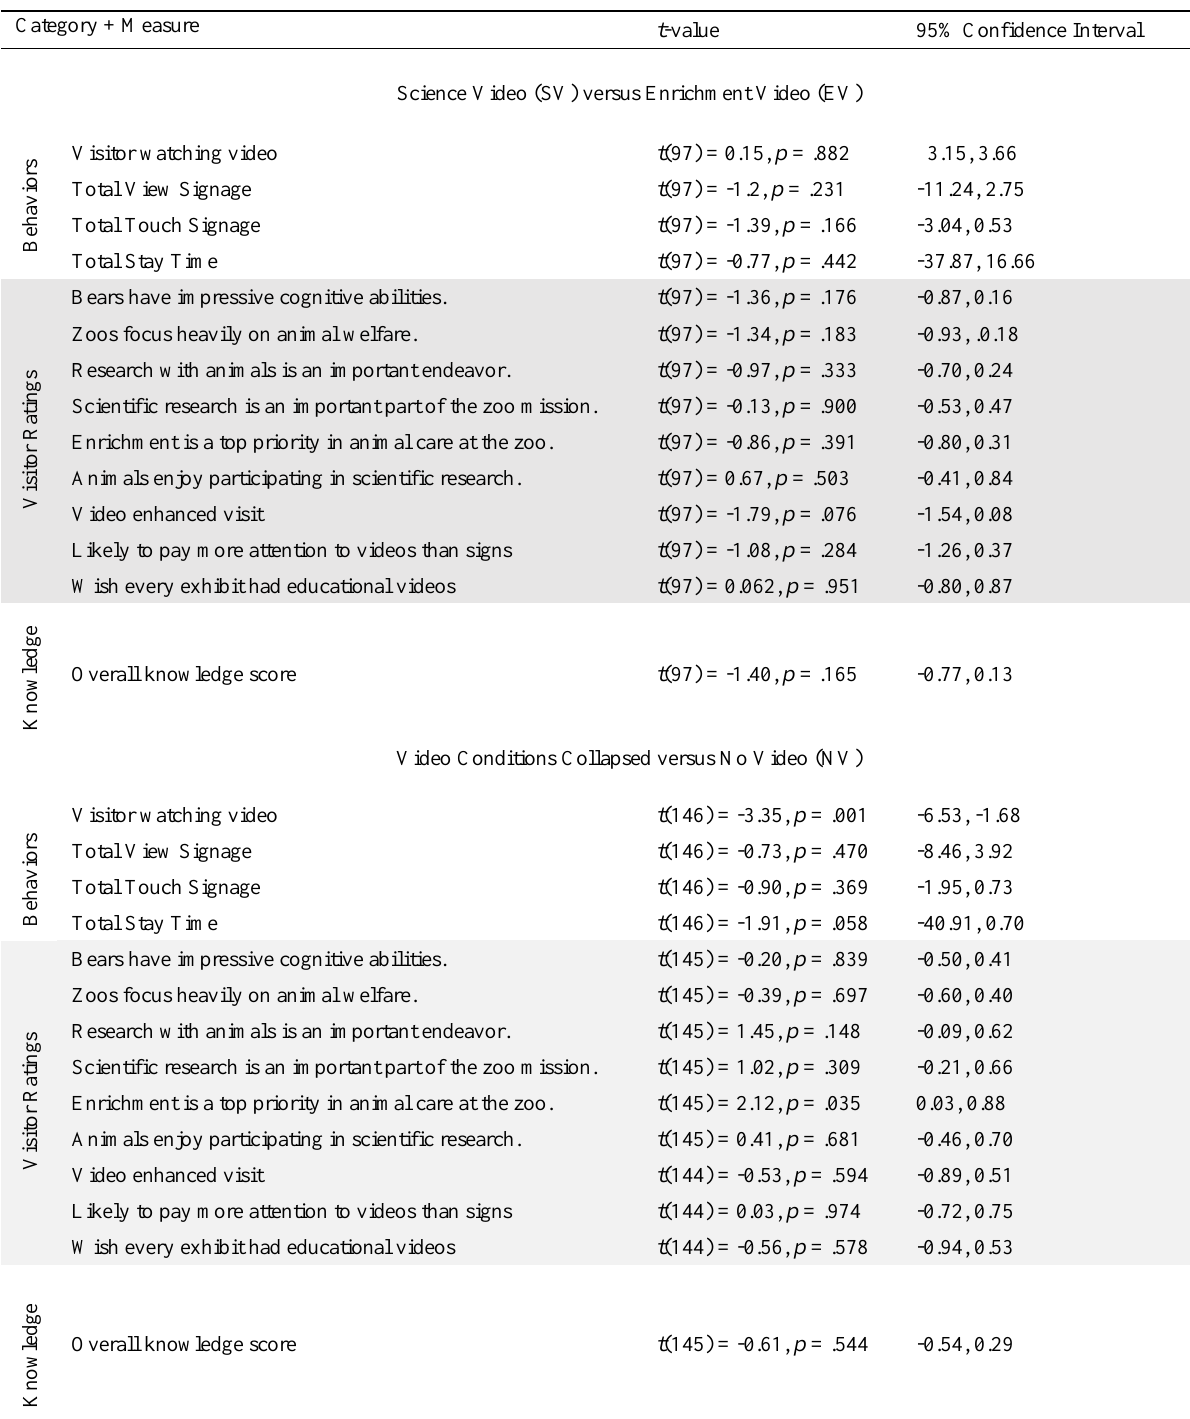
Statistical Output Comparing Various Measures in Science Video (SV) versus Enrichment Video (EV) and in in Video Conditions Collapsed versus No Video